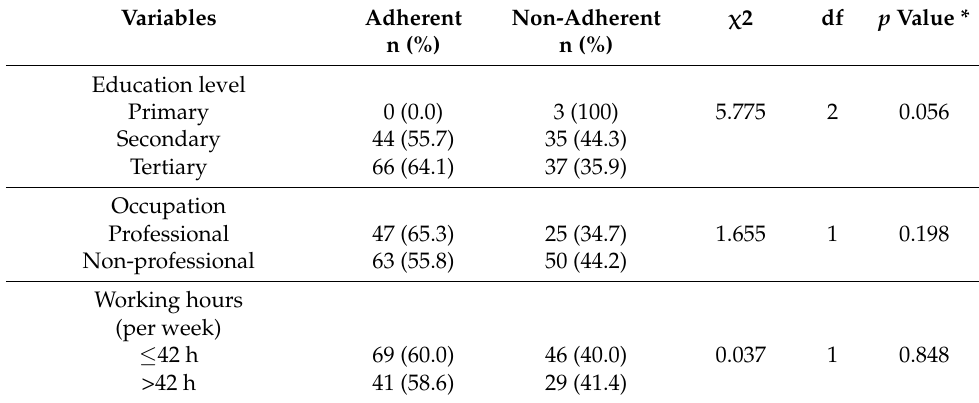
Table 2. The level of education, occupation and working